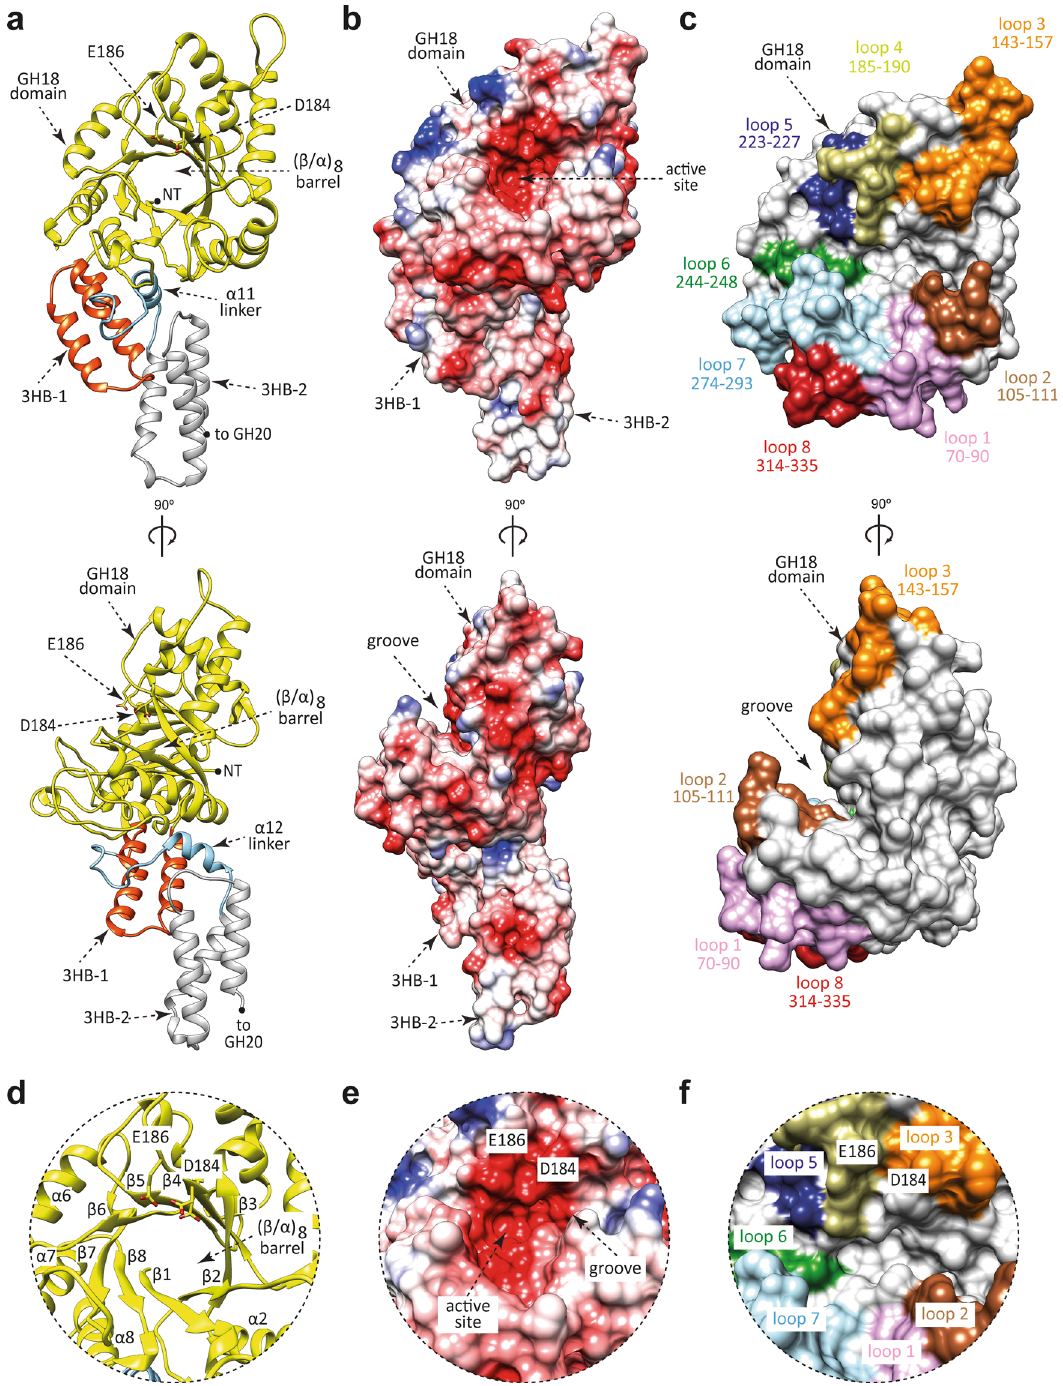
Fig. 2 The overall structure of the GH18 domain of EndoE. a Two cartoon representations showing the general fold and secondary structure organization of EndoE-GH18L, including the GH18 domain (yellow), the 3HB-1 (dark orange), and 3HB-2 (light gray) domains, and the α 12 linker (light blue). b Two electrostatic surface representations of EndoE-GH18L showing the location of the putative N -glycan binding site and the catalytic site. c Two surface representations of the GH18 domain of EndoE, with annotated domains and loops. d Close-up view of the active site of the GH18 domain of EndoE shown as cartoon/stick representation (yellow). e Close-up view of the active site of the GH18 domain of EndoE shown as electrostatic surface representation. f Close-up view of the active site of the GH18 domain of EndoE shown with annotated Structure of the GH20 domain of EndoE . We solved the crystal Fig. 4b). Alpha C protein is an invasin that participates in the structure of EndoE-GH20 by molecular replacement methods translocation of group B Streptococcus across human epithelial (PDB code 7PUL; Fig. 3; Supplementary Figs. 1 and 2; Supple- cells. It contains a three-helix bundle involved in the formation mentary Table 1 and Methods section). EndoE-GH20 crystallized of a potential heparin-binding site 51 .